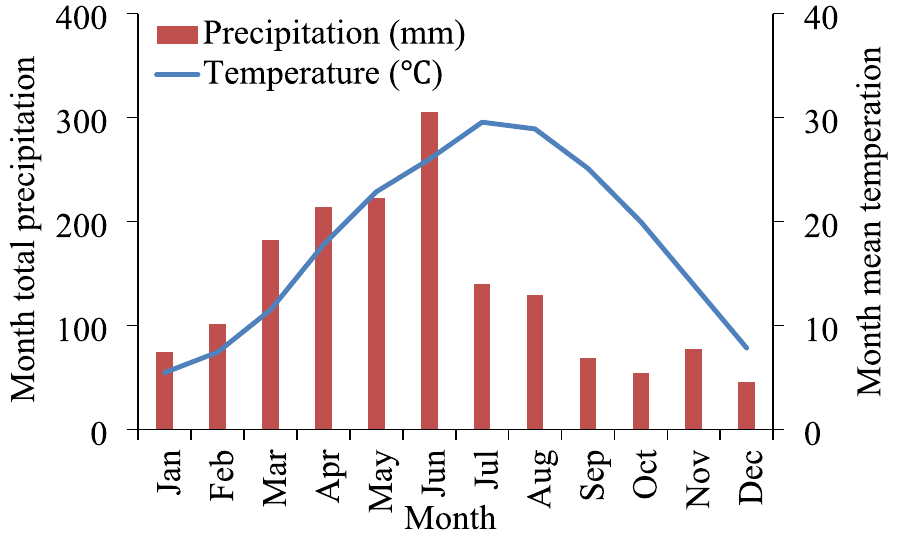
Figure 7. Monthly total precipitation and mean temperature from 1986 to